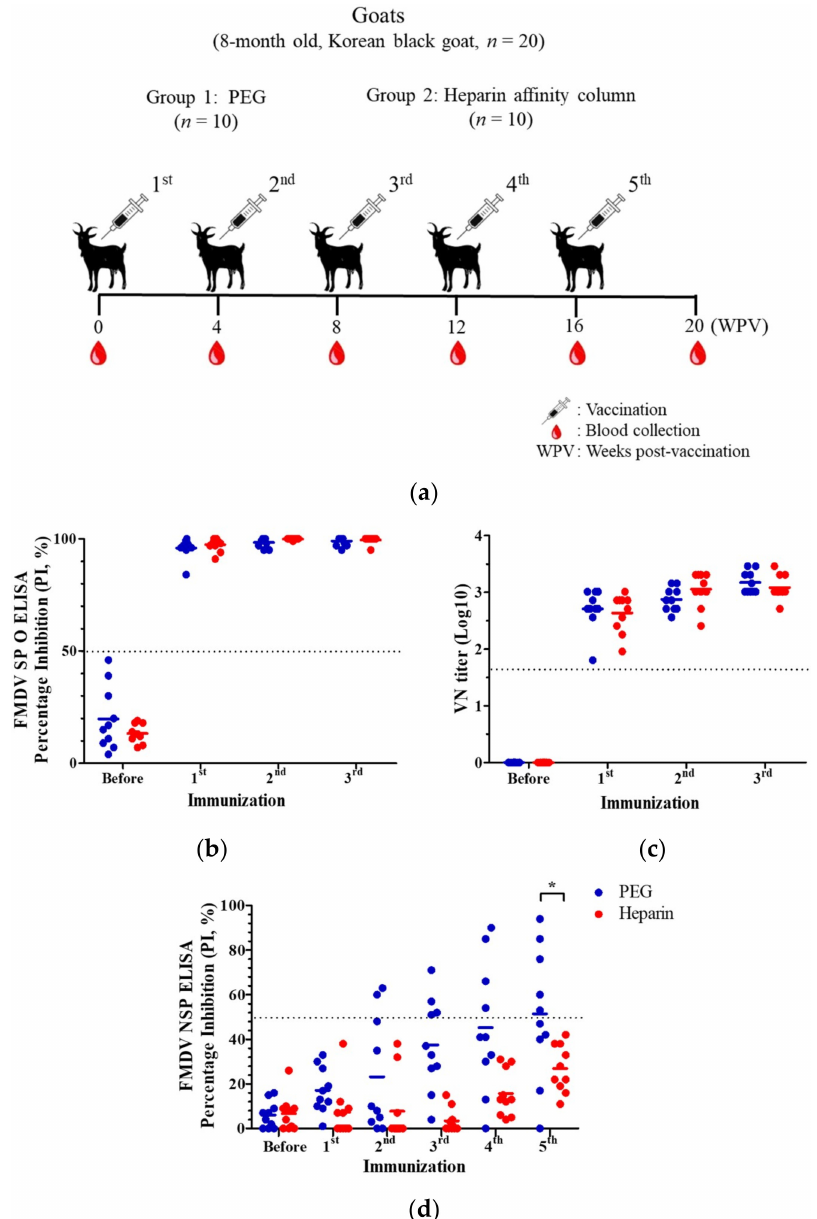
Figure 4. Antibody responses elicited by immunizations with polyethylene glycol (PEG)-treated and heparin a ffi nity column purified serotype O foot-and-mouth disease (FMD) Boeun / SKR / 2017 vaccines. ( a ) Scheme of the animal experiment. Twenty goats were vaccinated five times at a four-week interval with PEG-treated ( n = 10) and heparin a ffi nity column purified ( n = 10) FMD vaccines. Blood samples were collected every four weeks after vaccination. ( b ) The antibody titers of the structural proteins were measured via enzyme-linked immunosorbent assay (ELISA). The antibody values were expressed as percentage inhibition (PI) values. A PI value of ≥ 50% (dotted line) was considered to indicate positivity. ( c ) The homologous virus-neutralizing (VN) antibody titers were measured using the virus neutralization test. The VN titers were expressed as a log 10 value. A titer of ≥ 1.65 log 10 (dotted line) was considered to indicate positivity. ( d ) The antibody titers of the nonstructural proteins were measured via ELISA. The antibody values were expressed as PI values. A PI value of ≥ 50% (dotted line) was considered to indicate positivity. The full blue and red lines represent the mean PI values in each group. A significant di ff erence in the mean values between the two groups in the fifth vaccination was observed. * p <